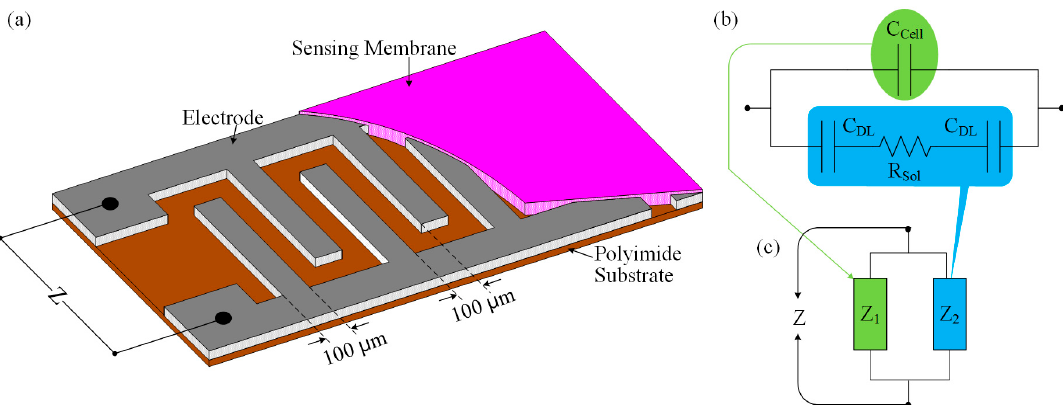
Figure 1. Interdigitated capacitor sensor: ( a ) schematic diagram of IDC sensing element; ( b ) simplified electrical circuit of the IDC; and ( c ) analogy of Figure 1b.